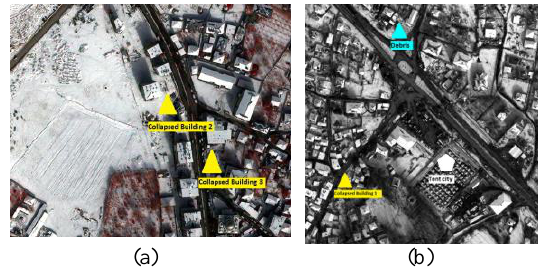
Figure 5: The collapsed buildings, debris area and tent city extracted from the streetview images for (a) Case area 1 and (b) Case area